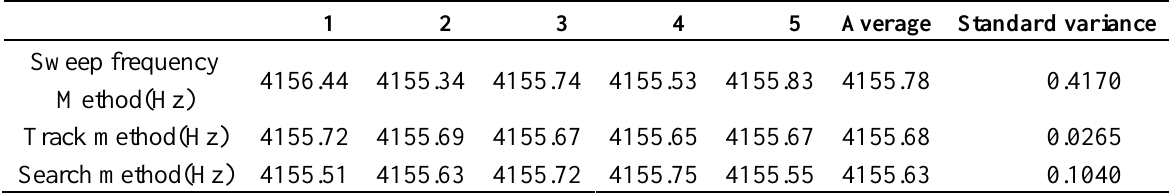
Table 5. Statistics of experimental results in normal